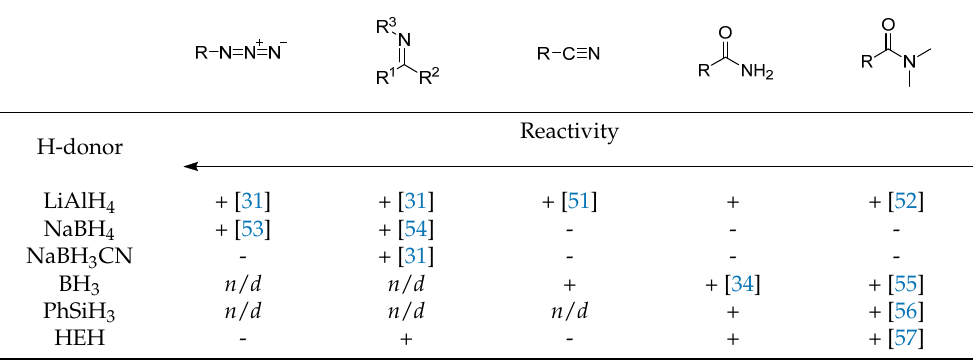
Table 2. Reducing agents and their Table 2. Reducing agents and their reactivities. Table 2. Reducing agents and their reactivities. Table 2. Reducing agents and their reactivities. Table 2. Reducing agents and their reactivities. Table 2. Reducing agents and their reactivities. Table 2. Reducing agents and their reactivities.